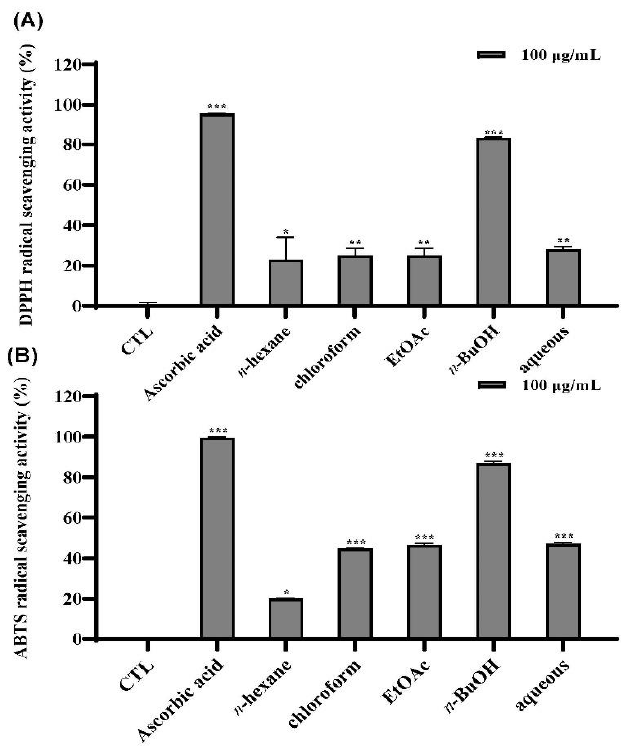
Figure 2. Effects of the fractions of I. rotunda twigs on DPPH ( A ) and ABTS ( B ) radical scavenging assays. The data are indicated as the mean ± SD ( n = 3) of three individual experiments. * p < 0.05, ** p < 0.01, and *** p < 0.001, compared with control.